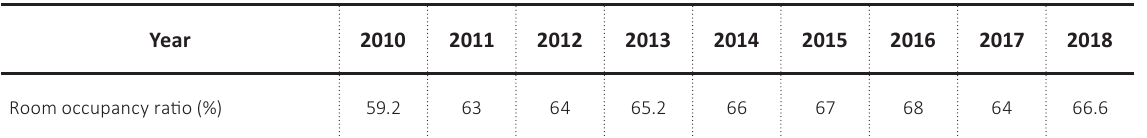
Source: Statista